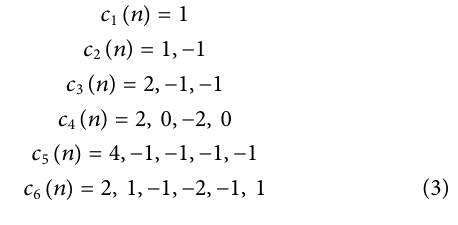
Frontiers in Signal Processing |